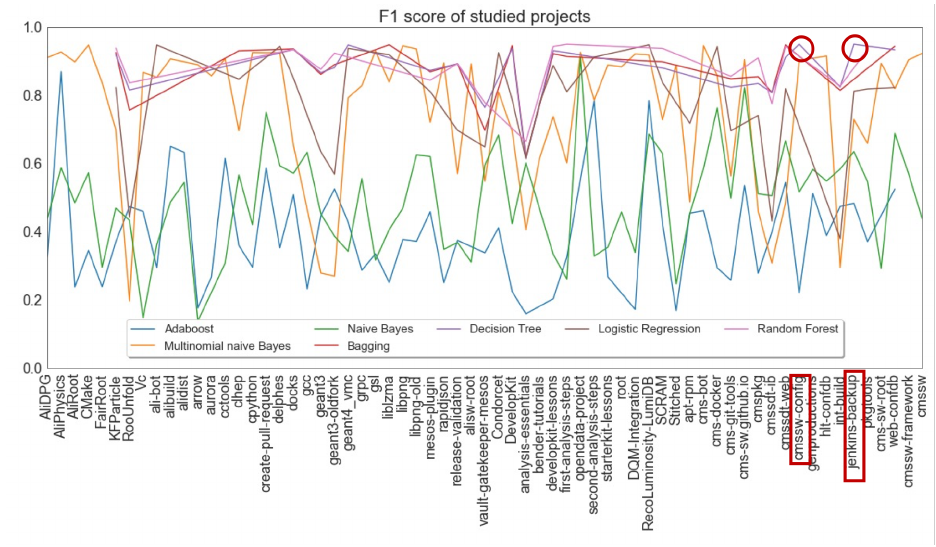
Figure 10. F1-score per